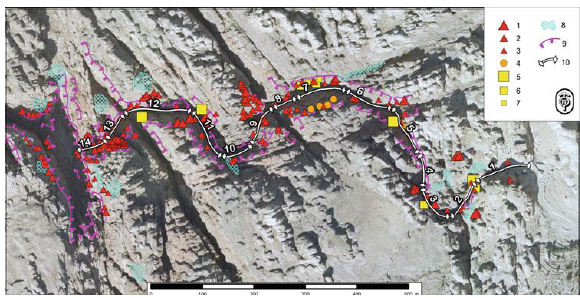
Figure 1. Landslide inventory map of the Petra area